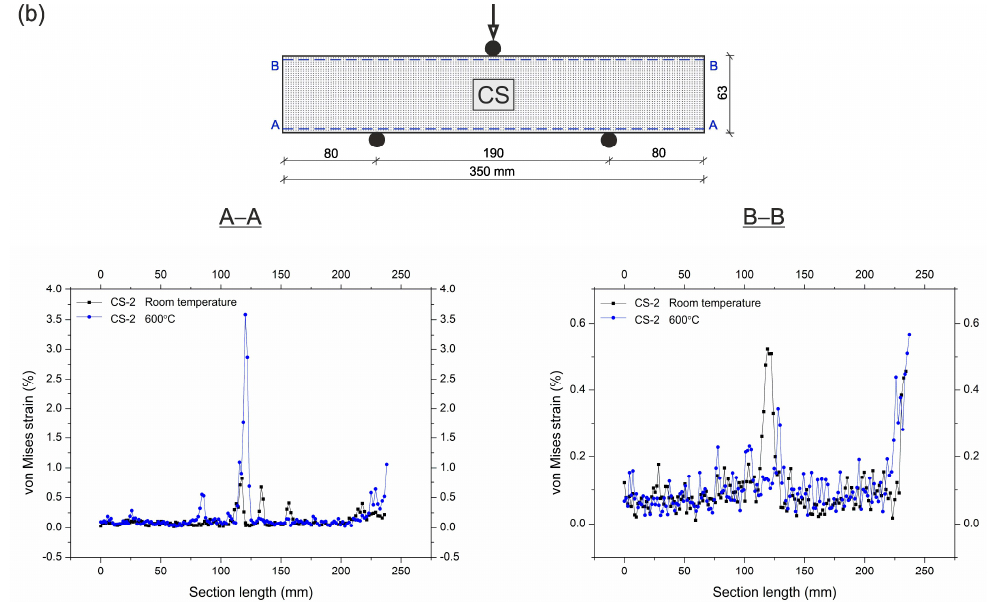
Figure 12. Comparison of von Mises strains at peak load, and at room temperature as well as after exposure to 600 °C in UHPC specimens with 2% ( a ) polypropylene fibre or ( b ) steel fibre content.